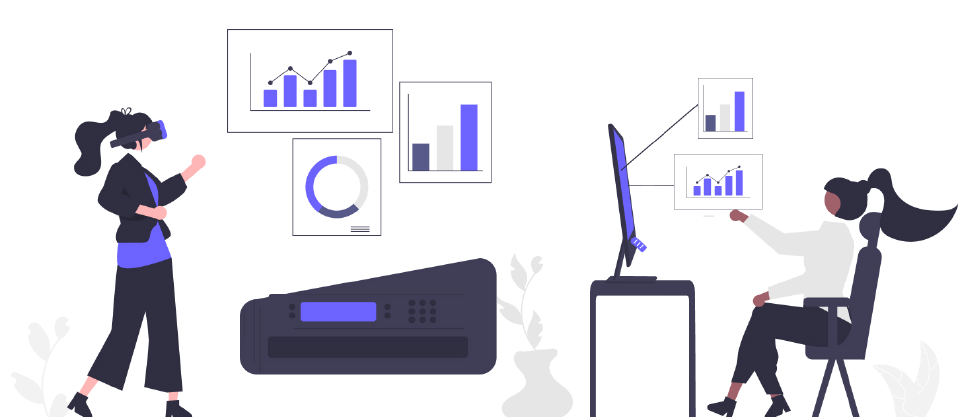
Figure 1. The Augmented Digital Control Room: Multimodal Collaborative Interaction Techniques.